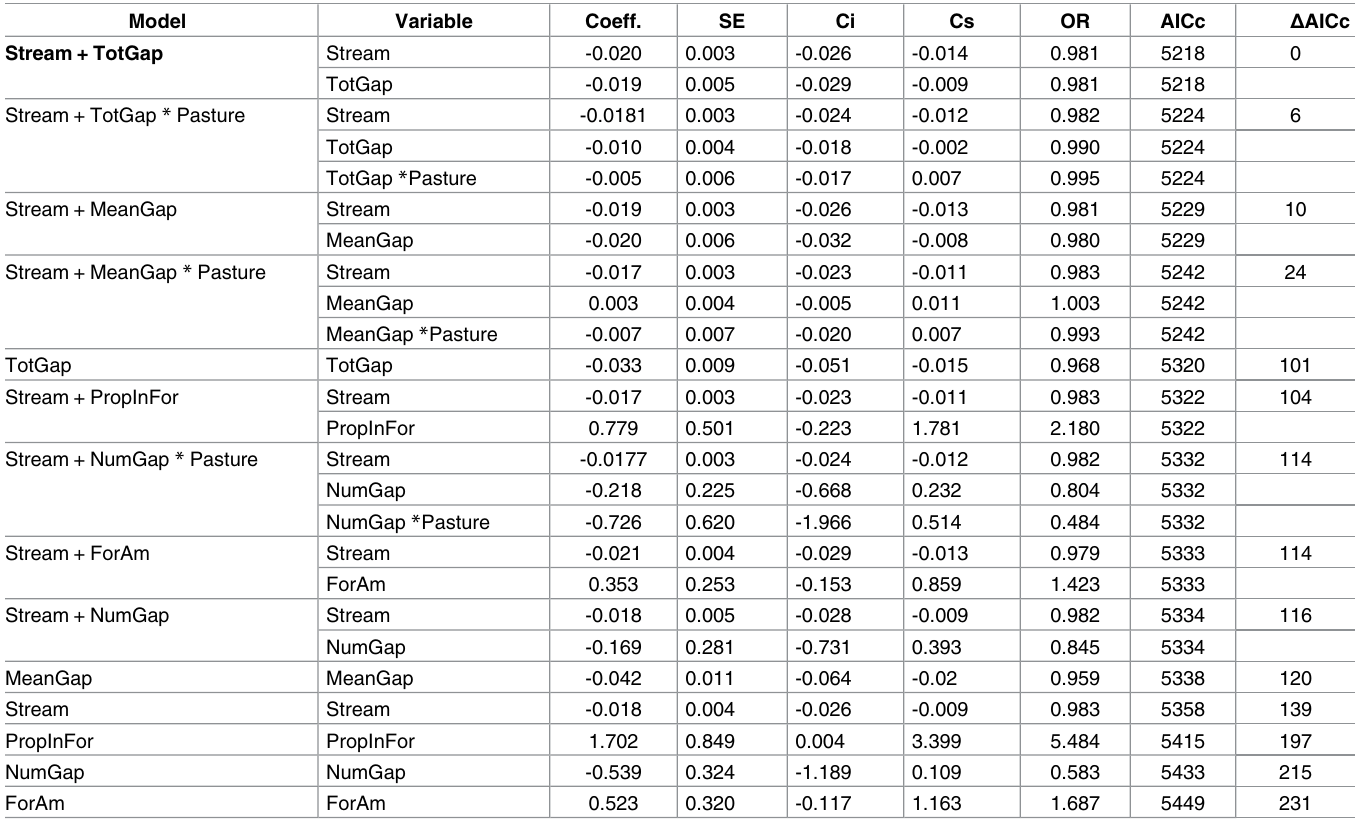
Table 1. Model coefficients, standard errors, confidence intervals, odds ratios and AICc values for the candidate models used to predict observed hummingbird movement steps in relation to random unused steps as a function of the following variables. The top-ranked AICc model is